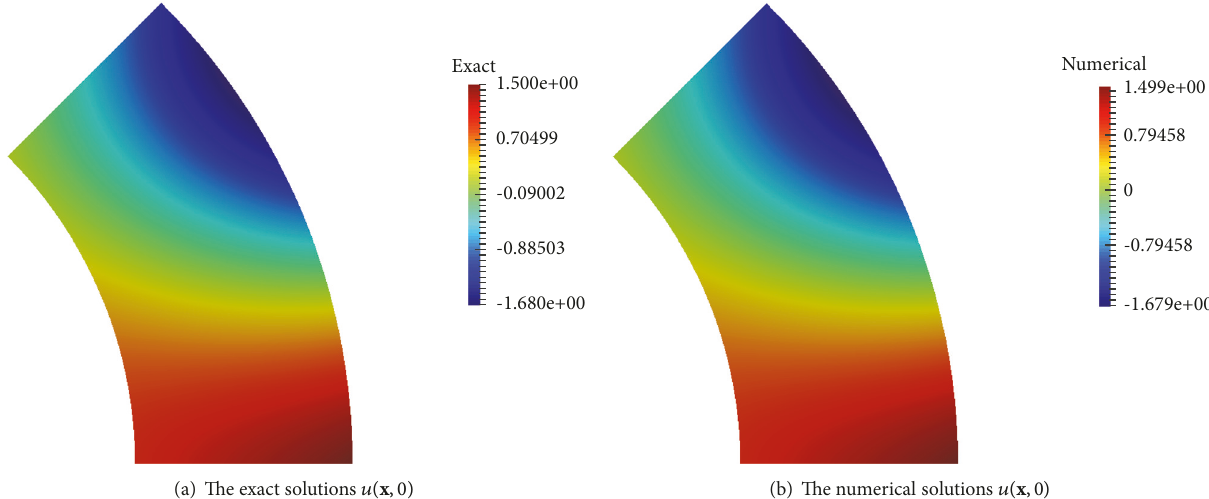
Figure 5: The figure with 𝑎 = 1.0 , 𝑏 = 1.5 , 𝑐 = 0 , 𝑑 = 1.0 , and 𝜃 = 𝜋/4 .